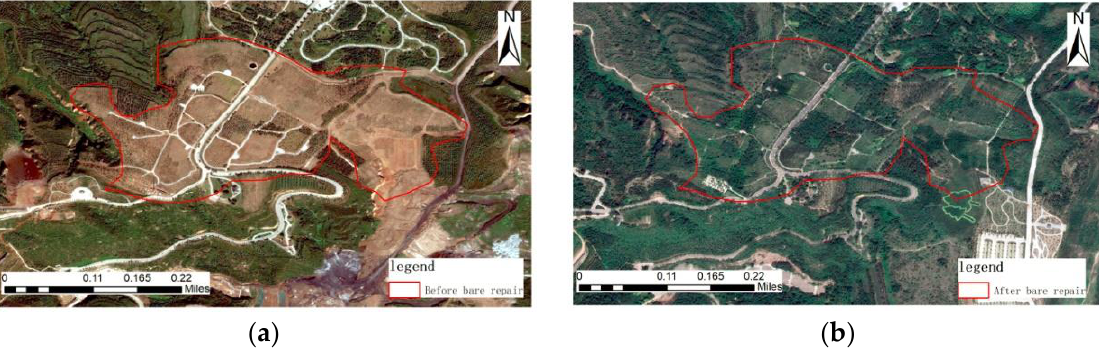
Figure 12. Remote sensing images before and after ecological restoration of the bare land regreening area. ( a ) before treatment; ( b ) after treatment.